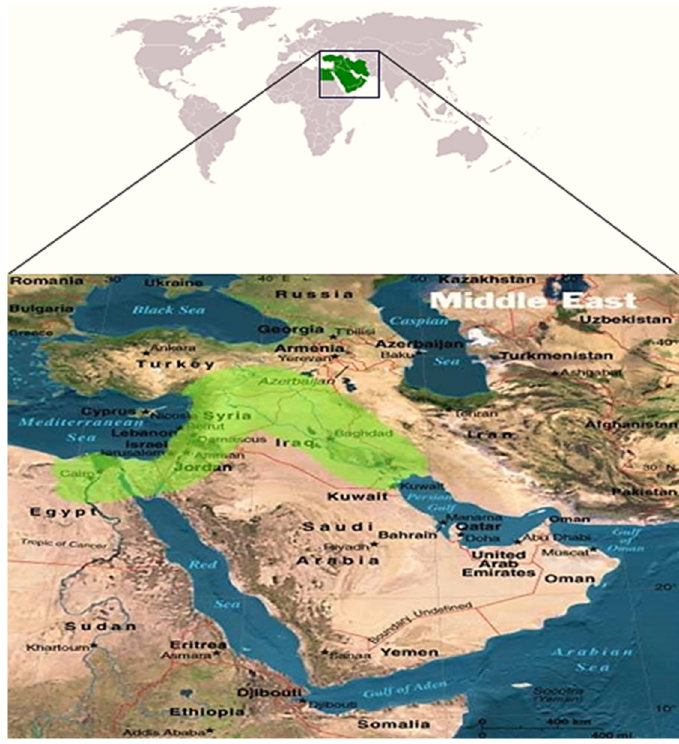
Figure 1. The position of the Fertile Crescent (FC) in the Middle East and world. This region embraces a wide geographical range between the Persian Gulf and the eastern coast of the Mediterranean Sea (highlighted in green).